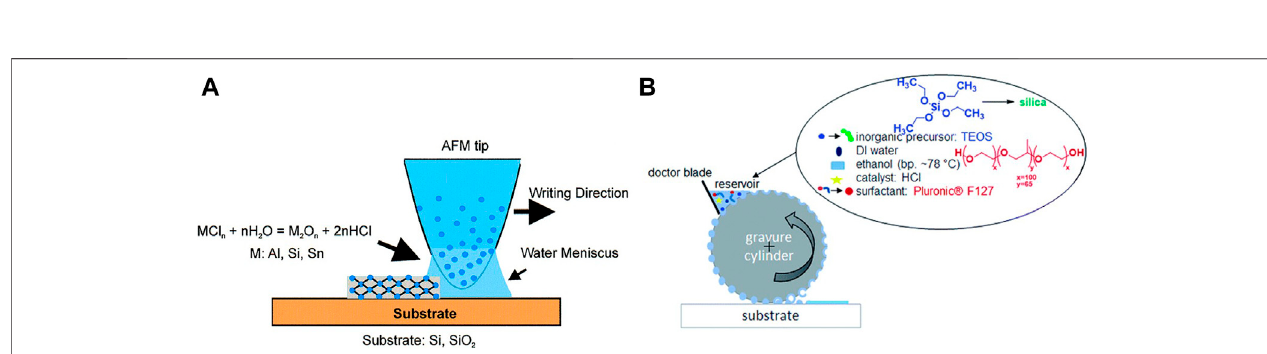
FIGURE3| Schematicsfordip-pennanolithography (A) andgravureprinting (B) basedonsol-gelinks.ReprintedwithpermissionfromSuetal.(2002),copyright © 2002 American Chemical Society. Permission from Herzog et al. (2019) was granted, published by The Royal Society of Chemistry.